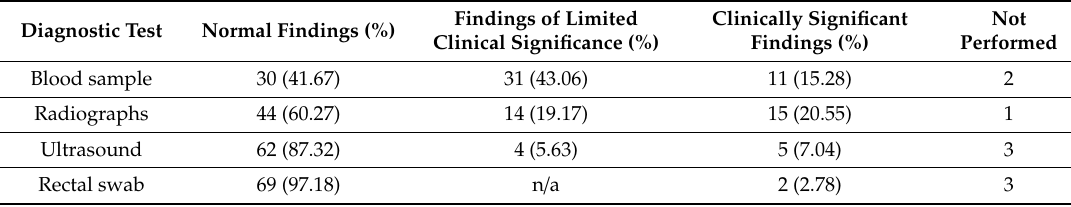
Table 6. Frequency of diagnostic tests performed (% of procedures for which tests were carried out), by outcome